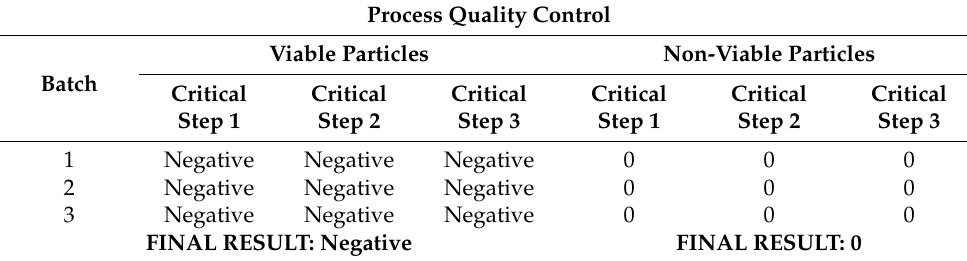
Table 6. Process quality